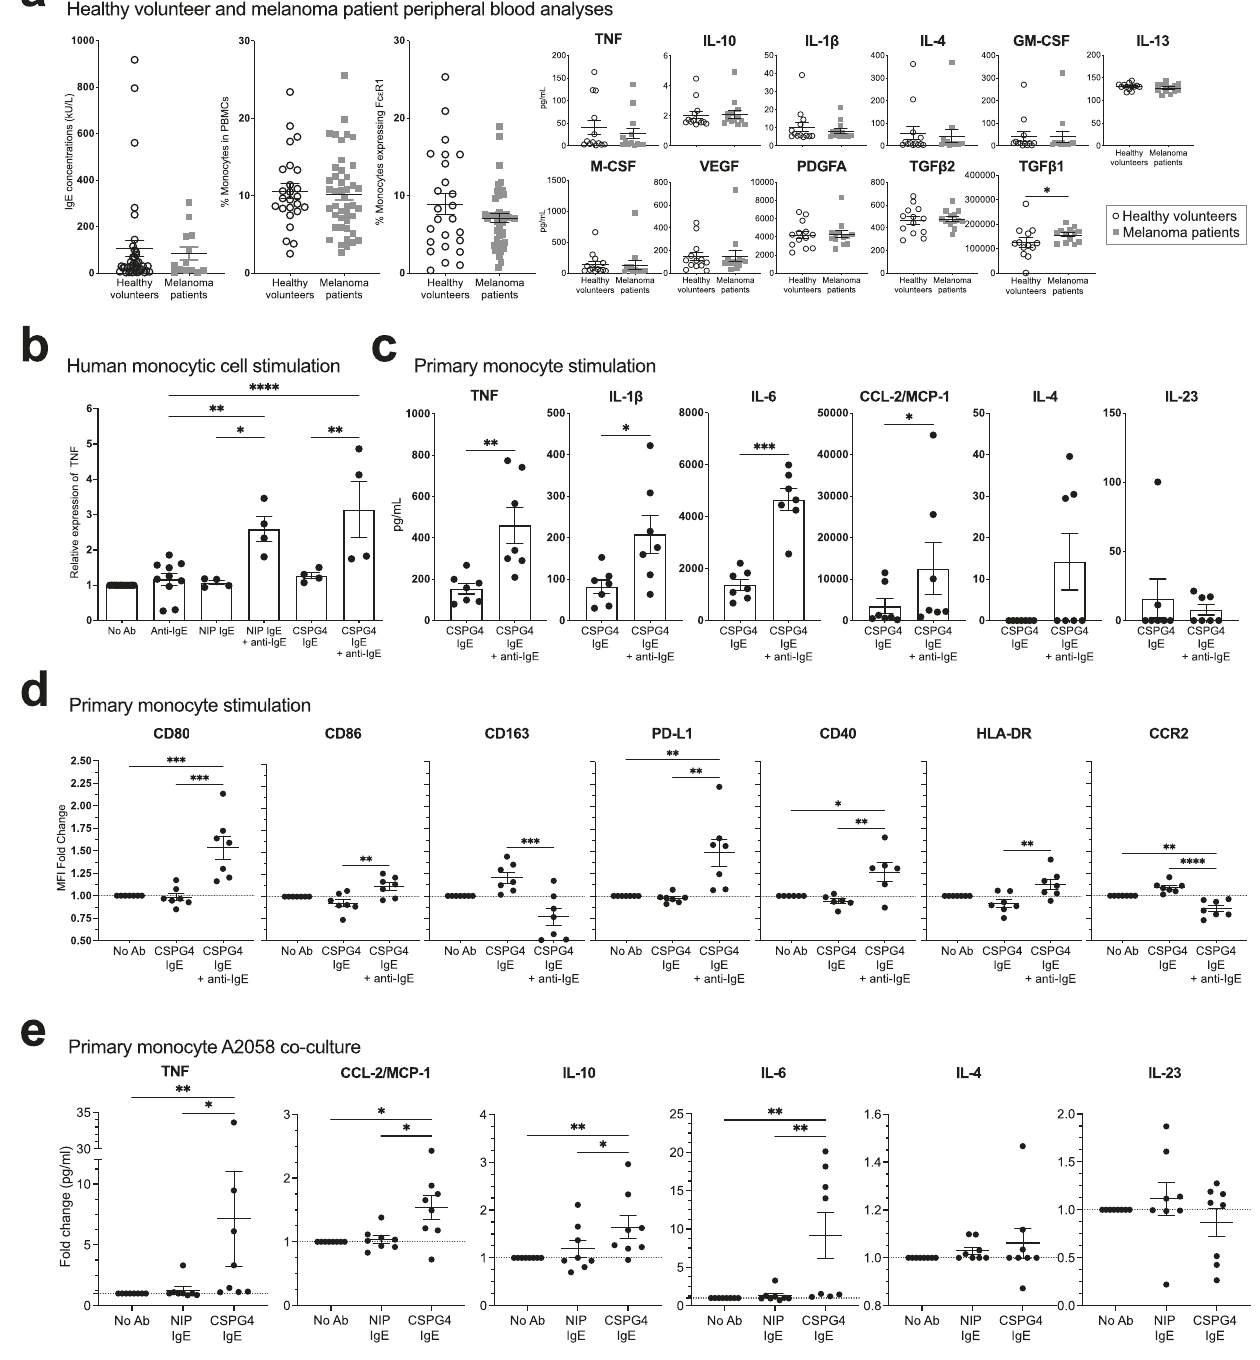
Fig. 4 | Cross-linking of CSPG4 IgE on the surface of human monocytes pro- motes secretion of pro-in fl ammatory cytokines and enhanced expression of co-stimulatorycell-surfacemarkers.a SerumanalysisoftotalIgElevelsinhealthy volunteers ( n =38) and melanoma patients ( n =13). Flow cytometric analysis of % monocytes in total PMBCs (healthy volunteers, n =25; melanoma patients, n =44) and % of monocytes expressing Fc ɛ RI (healthy volunteers, n =25; melanoma patients, n =46).Concentrationsofcytokinesandchemokinesmeasuredinthesera of sex-matched healthy volunteers ( n =13) and melanoma patients ( n =13) ( p =0.0387). b QuantitativePCR(qPCR)analysisofTNFexpressionfollowingcross- linking of human IgE bound to human monocytic U937 cells ( n =4 independent experimental repeats). Anti-IgE vs. CSPG4 IgE + anti-IgE, p ≤ 0.0001; Anti-IgE vs. NIP IgE + anti-IgE, p =0.0039; NIP IgE vs. NIP IgE + anti-IgE, p =0.0113; CSPG4 IgE vs. CSPG4 IgE + anti-IgE, p =0.0014. c Cytokine and chemokine secretion in primary monocyte culture supernatants following cross-linking of IgE ( n =7 healthy